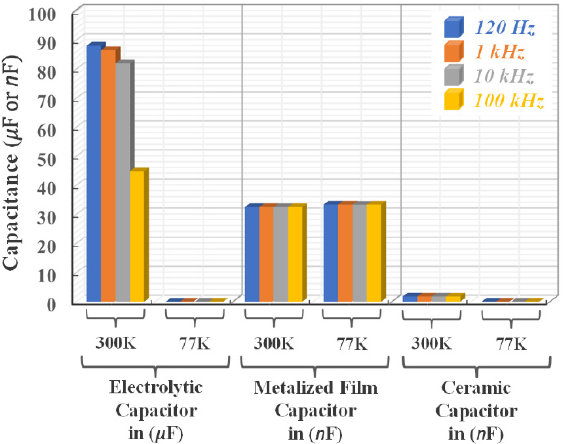
Figure 12. Comparative analysis of the capacitance values for specified types of capacitors under different frequencies at room and cryogenic temperatures.